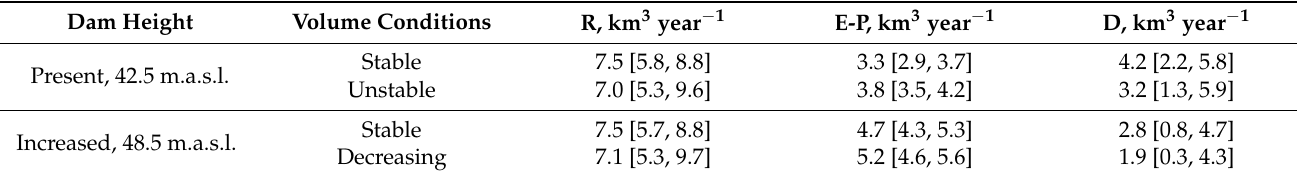
Table 1. Summary of the water balance conditions under the RCP 8.5 scenario given for the cases of present and increased dam height. Mean annual values of river inflow (R), evaporation minus precipitation (E-P) and Kokaral outflow (D) are shown for stable and unstable periods of volume conditions. Maximum and minimum values for each component during the periods are given in